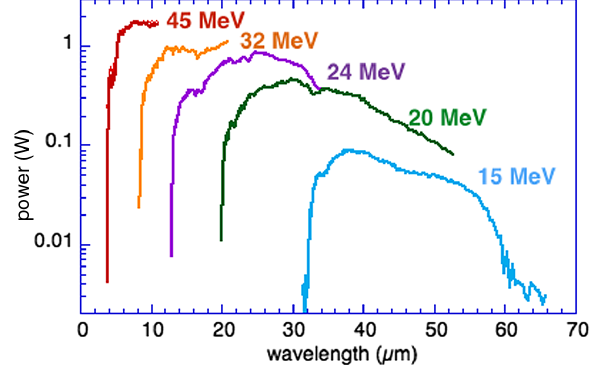
FIG. 11. Measurements of the CLIO laser power vs wave- length, for various electron beam energies.